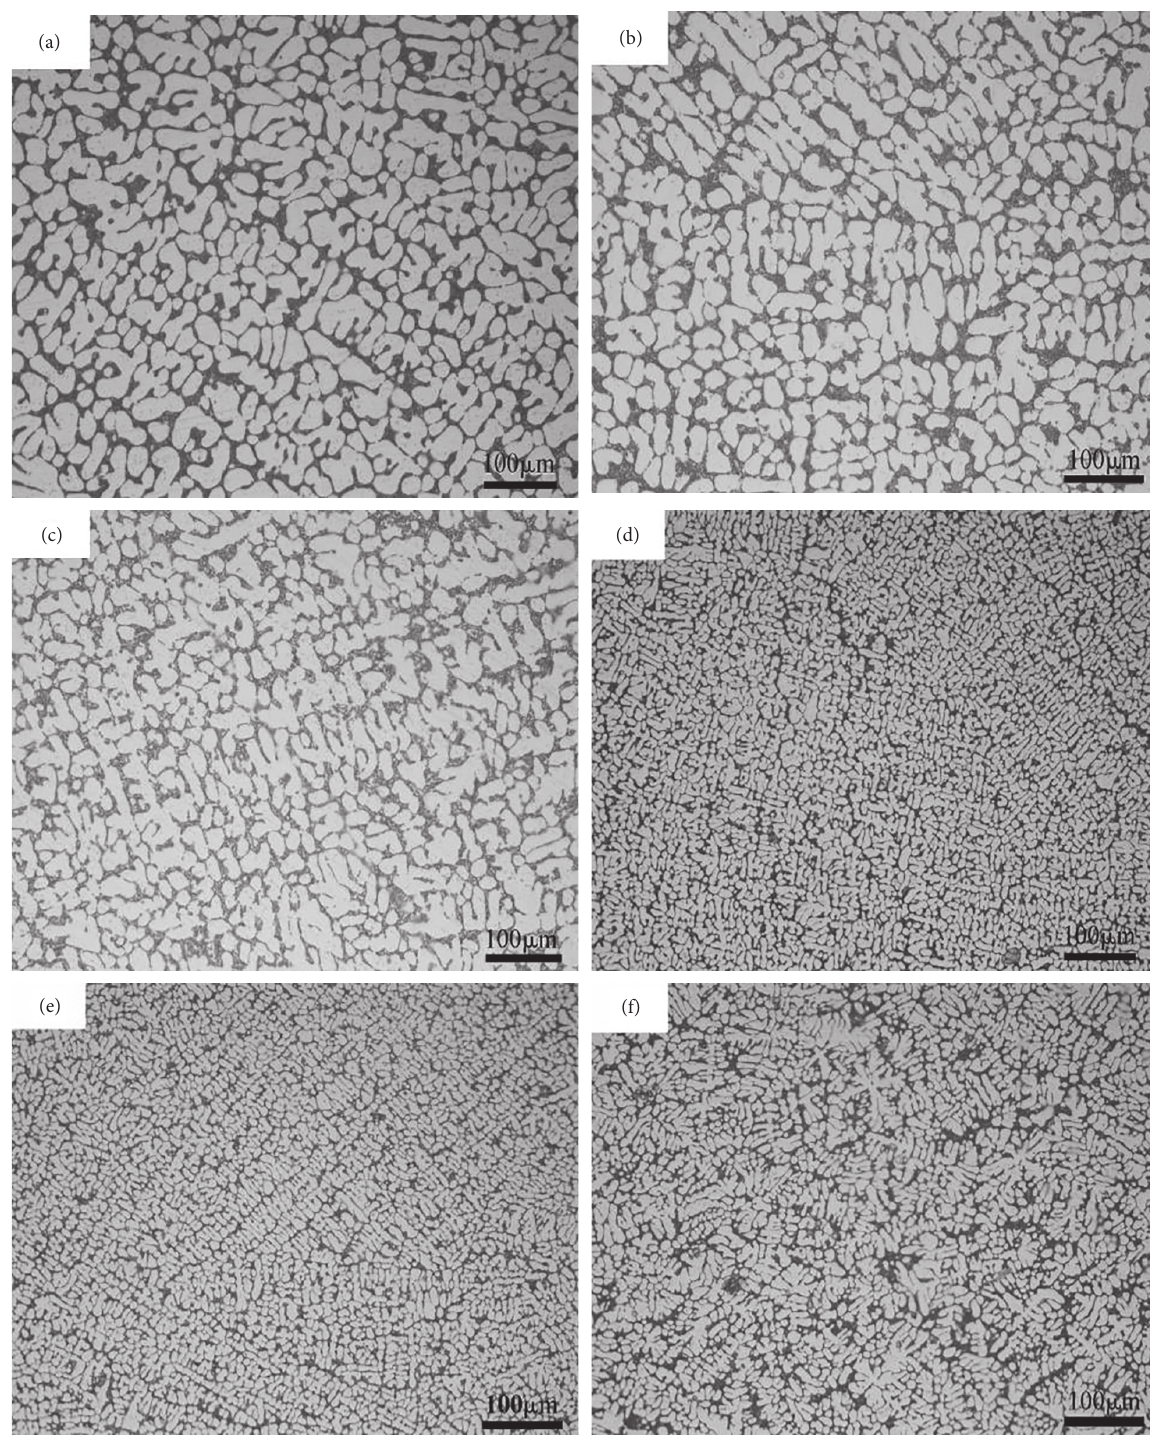
Figure 6: Optical microstructures of hybrid nano-(SiCp +TiCp)/Al composites: (a) 2 vol% hybrid nano-(SiCp +TiCp)/Al; (b) 2 vol% nano- SiCp/Al; (c) 2 vol% nano-TiCp/Al; (d) 3 vol% hybrid nano-(SiCp +TiCp)/Al; (e) 3 vol% nano-SiCp/Al; (f) 3 vol%